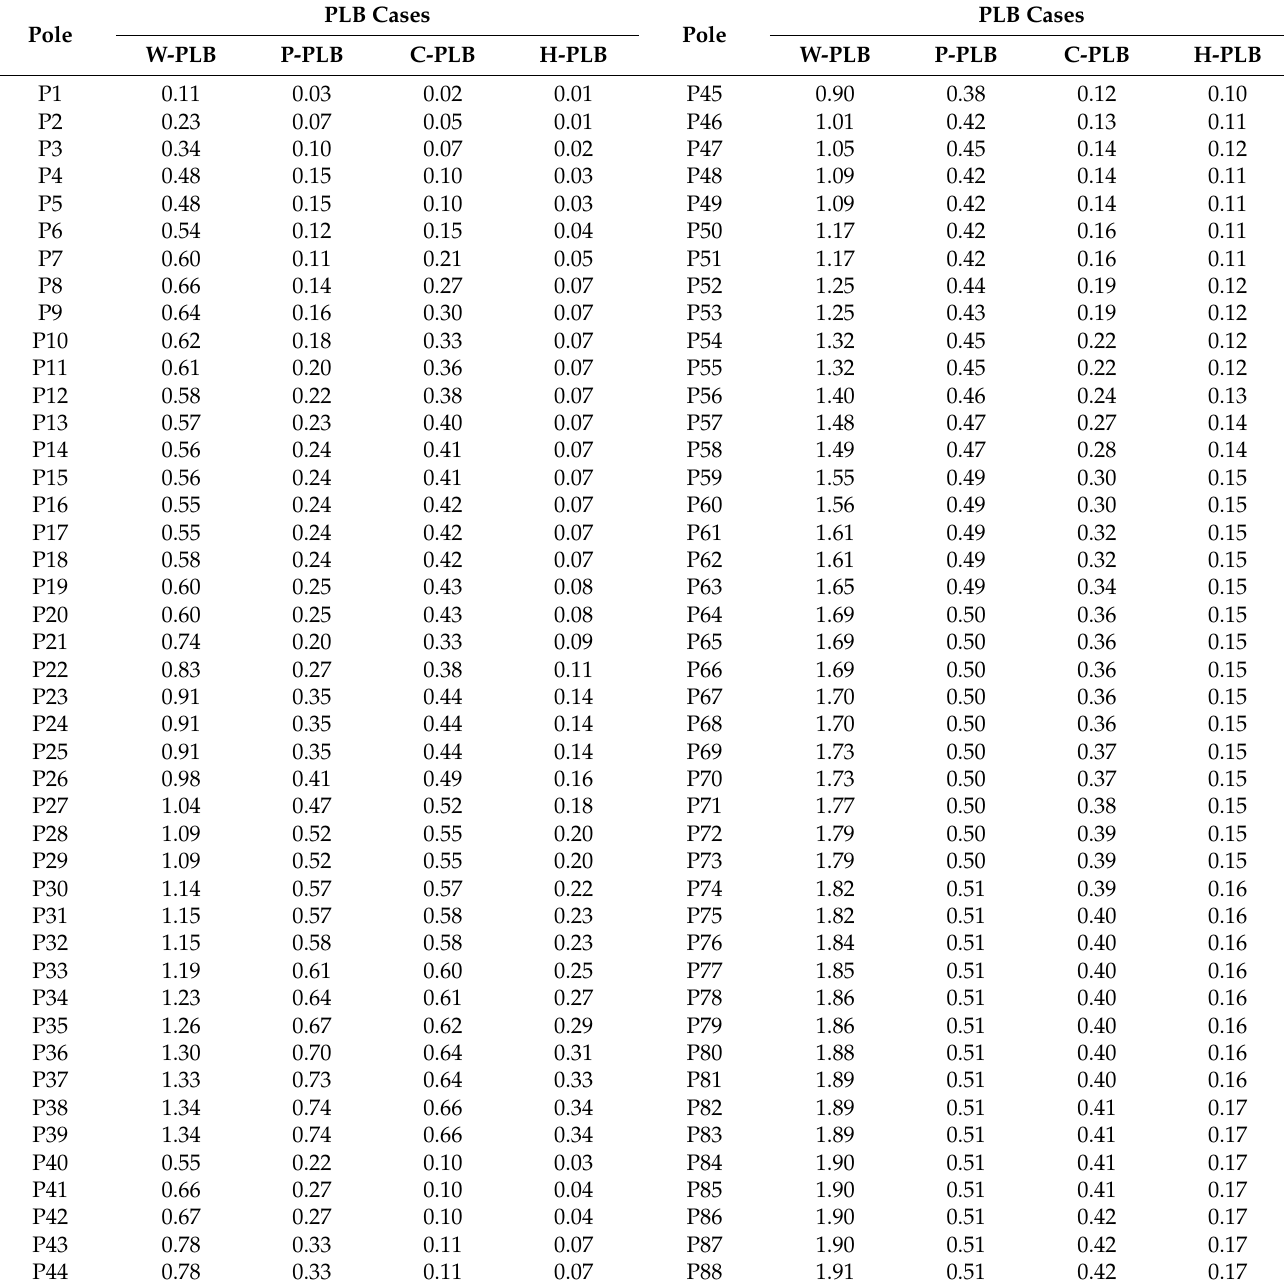
Table 10. The average values of the PVUR calculated at the level of each pole from in the analysed cases, in (%).